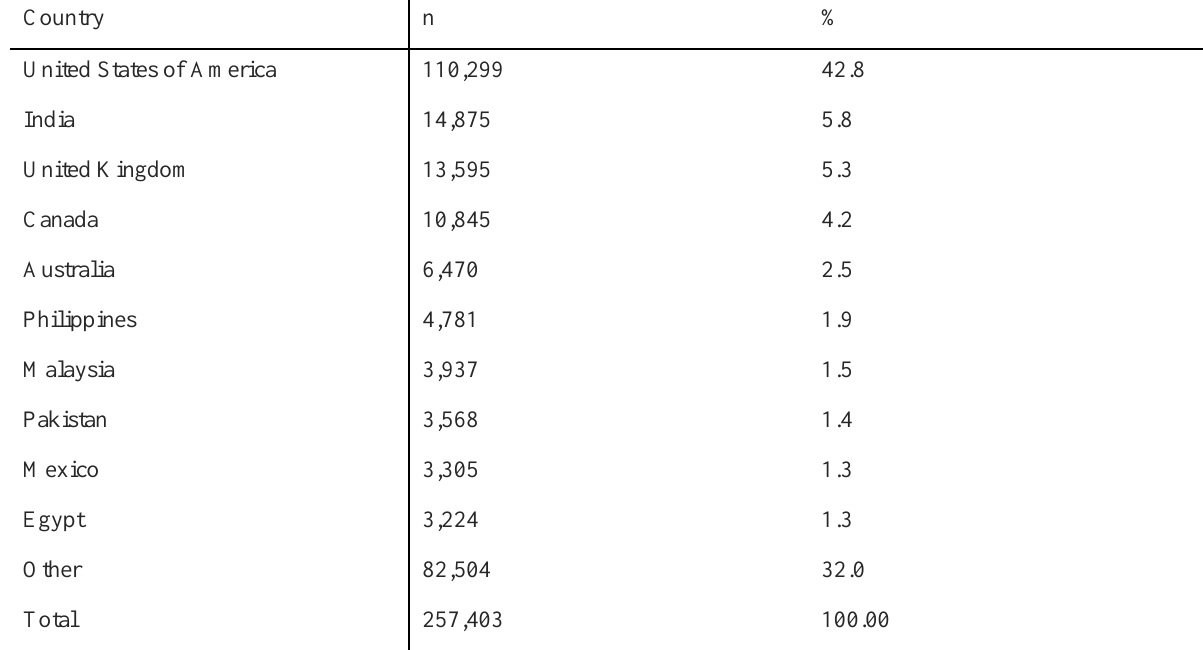
Table I: Visits to Supercourse Webpage by Country/Territory